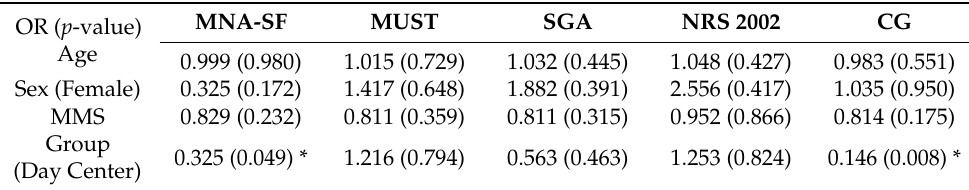
Table 5. Odds ratios (OR) for nutritional risk/malnutrition identification. MNA-SF MUST OR ( p -value) Age